Question: Condense the content of this figure into a single sentence.
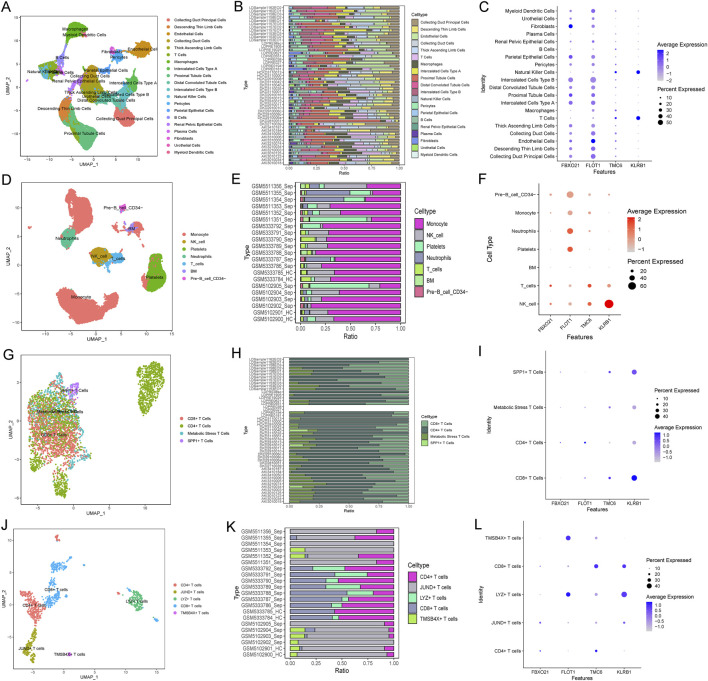
Answer: Single-cell RNA sequencing landscape and cell-specific expression analysis of shared hub genes in AKI and sepsis. (A–C) Characteristics of the single-cell atlas in the AKI dataset. (A) UMAP dimensionality reduction plot of all cell types, visualizing major cell populations including renal tubular epithelial cells and immune cells. (B) Stacked bar plot illustrating the relative abundance proportions of cell types across different samples. (C) Bubble plot displaying the expression profiles of the four shared hub genes ( FBXO21 , FLOT1 , TMC6 , KLRB1 ) in major cell types of AKI. The size of the dot corresponds to the percentage of cells expressing the gene, while the color intensity indicates the average expression level. (D–F) Characteristics of the single-cell atlas in the sepsis dataset. (D) UMAP plot of major cell types in peripheral blood, including neutrophils, monocytes, and T cells. (E) Proportional distribution of cell types in sepsis samples compared to control samples. (F) Bubble plot showing the expression of shared hub genes in major cell types of sepsis. (G–I) Re-clustering analysis of T-cell subsets in AKI. (G) UMAP plot of T-cell subsets, identifying four distinct clusters: CD4 + T cells, CD8 + T cells, Metabolic Stress T cells, and SPP1 + T cells. (H) Proportions of each T-cell subset across samples. (I) Expression characteristics of hub genes within different T-cell subsets of AKI. (J–L) Re-clustering analysis of T-cell subsets in sepsis. (J) UMAP plot of T-cell subsets, identifying characteristic clusters including CD4 + , CD8 + , as well as JUND + , LYZ + , and TMSB4X + T-cell subsets. (K) Proportional distribution of each T-cell subset. (L) Expression characteristics of hub genes within different T-cell subsets of sepsis.